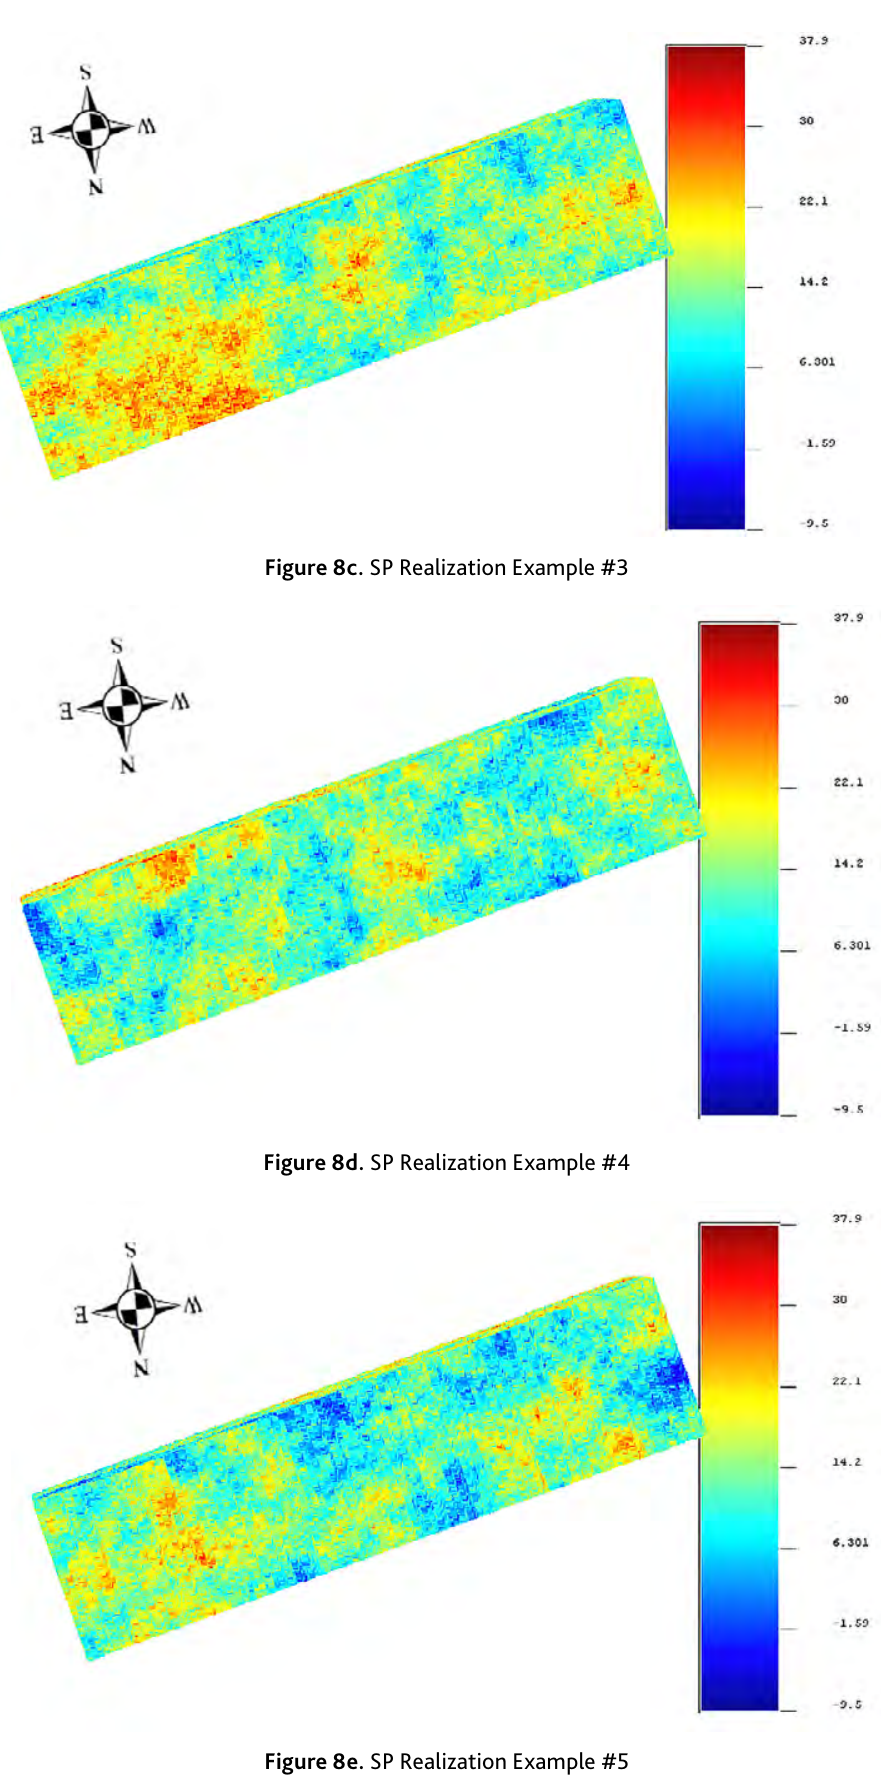
Figure 8e. SP Realization Example #5